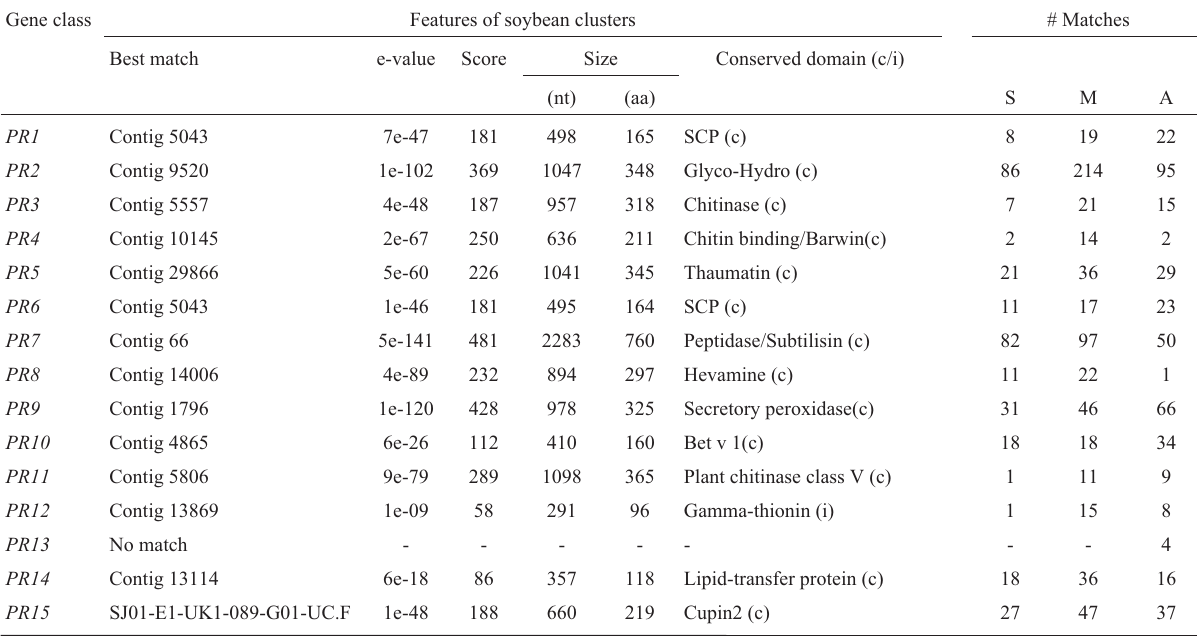
Table1 - Soybeanclustersmatchingresultsforeachprocured R and PR gene.Showingnumberofmatchesforeachseed-sequence,e-value,score,sizein nucleotide(nt)andamino-acid(aa),presenceofconserveddomainsandnumberofmatchesinsoybean(S) Medicago (M)and Arabidopsis (A).Abbrevia- tions: (c) = Complete; (i) =